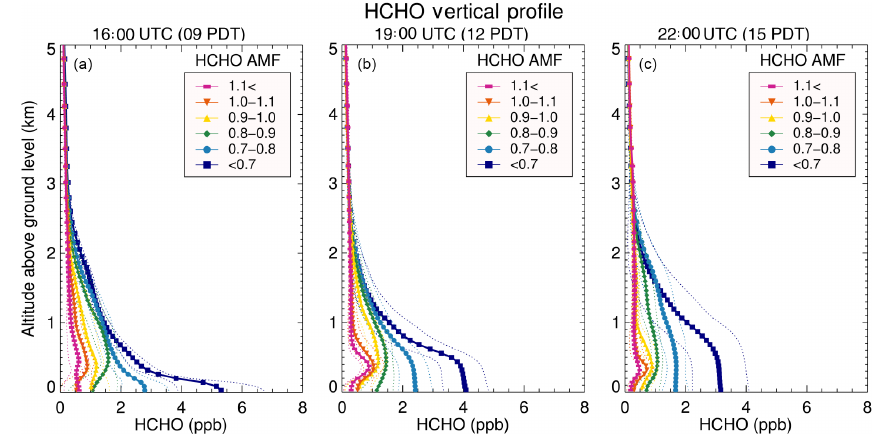
Figure 5. Vertical profiles of HCHO averaged for the AMF value intervals (as in legends) at 16:00, 19:00, and 22:00UTC (a–c) are displayed. Thick lines with symbols are for averages and thin dotted lines are for 1 standard deviation values. The altitude above ground level is shown. The same plot with the unit of moleculescm − 3 is shown in the Supplement.